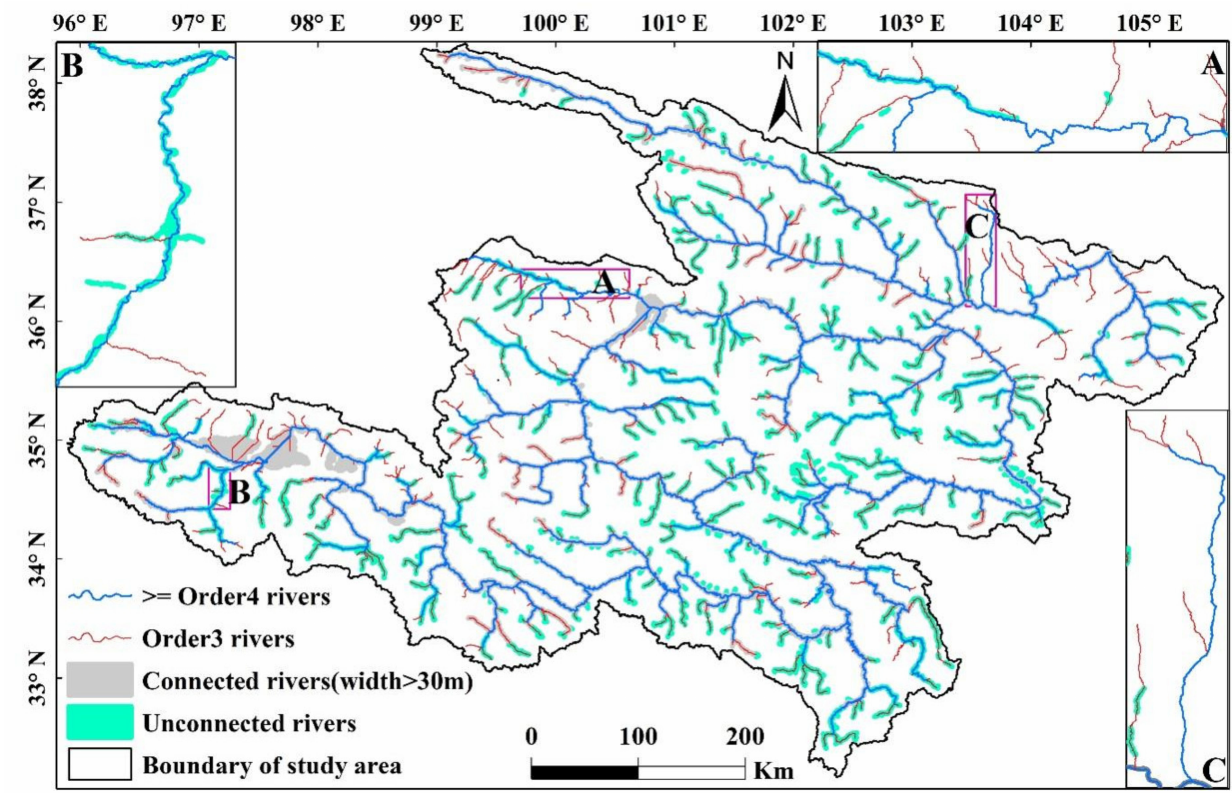
Figure 7. Comparisons between all the extracted rivers and drainage networks above order 2 that were generated from a 90-m resolution